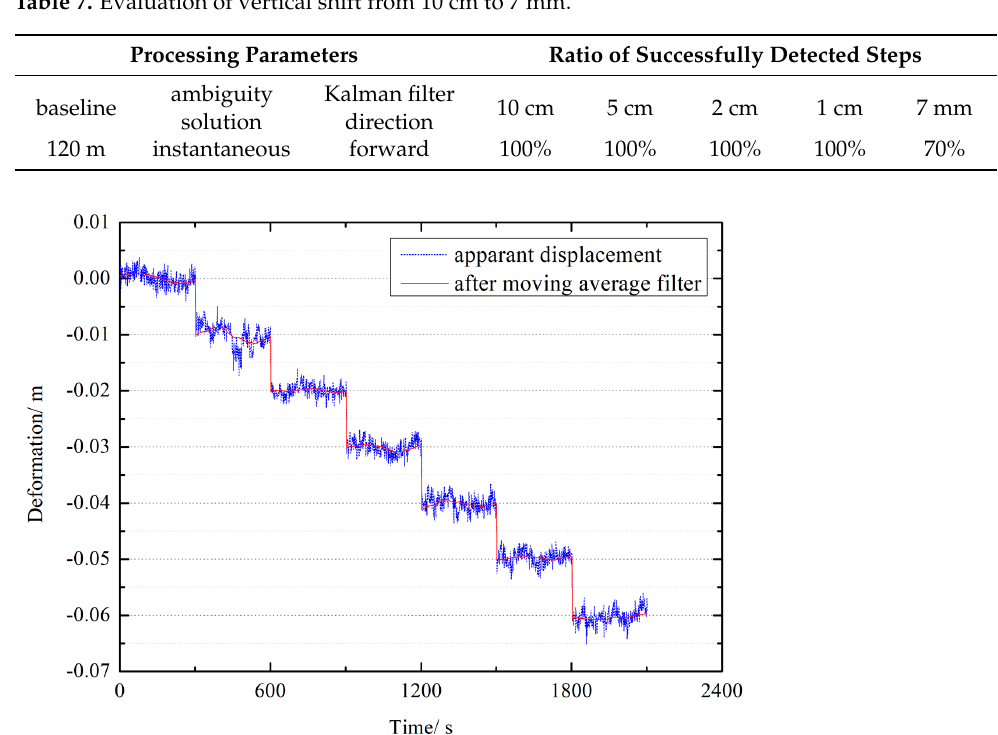
Table 7. Evaluation of vertical shift from 10 cm to 7 mm.